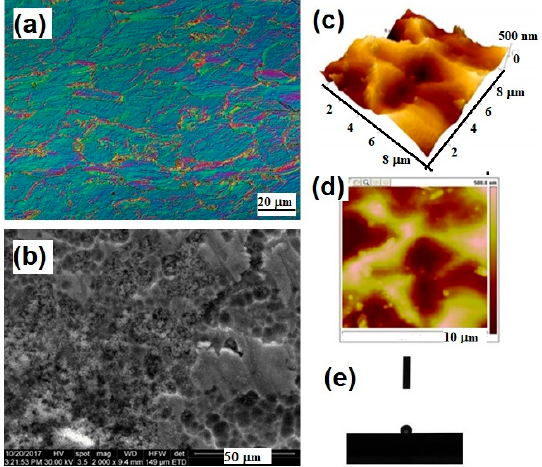
Figure 2. Surface properties of Ti mesh for cranioplasty evidenced by different microscopic techniques: ( a ) light microscopy image in phase contrast, longitudinal section, 500×, Kroll reagent; ( b ) Scanning Electron Microscopy 2000×; ( c , d ) 3D and 2D Atomic Force Microscopy images; ( e ) contact angle investigation on the surface of the titanium mesh.